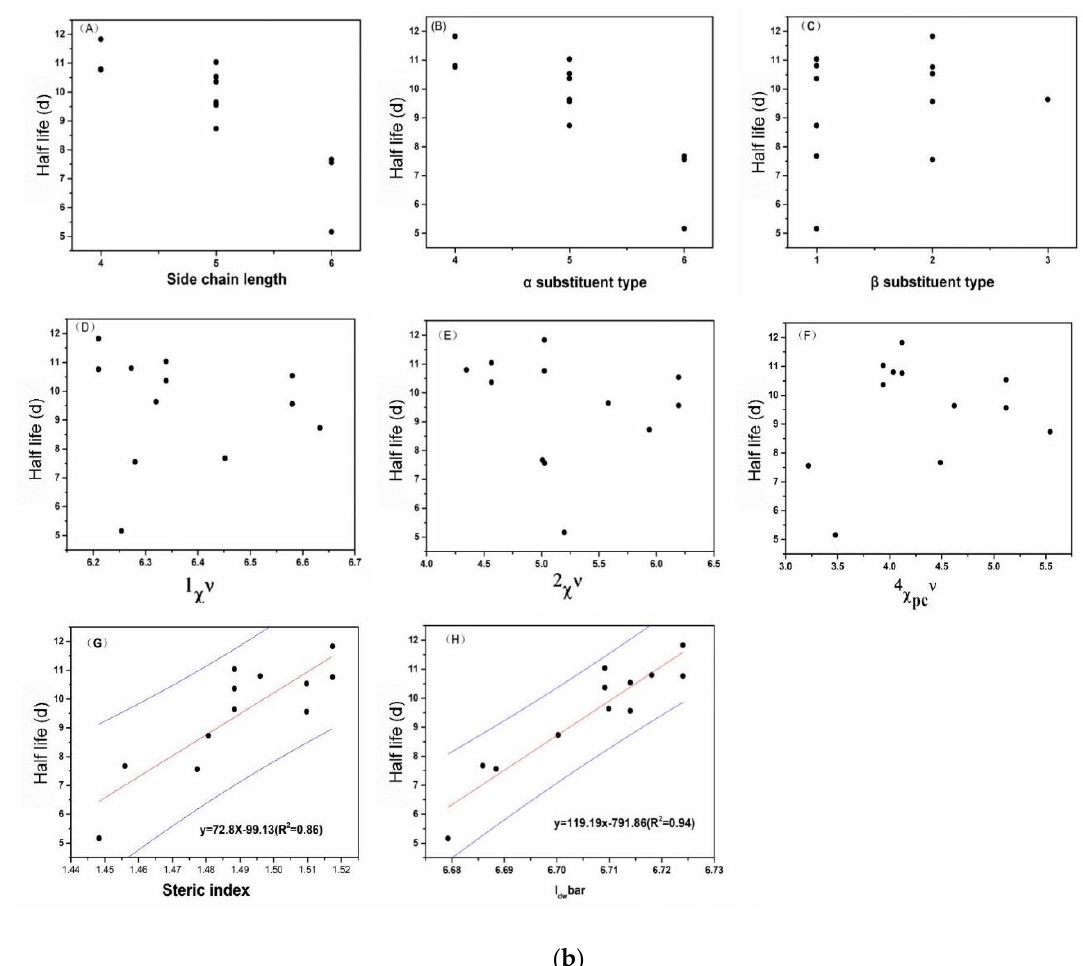
Figure 2. The relationship between the half-life of NP isomers and the structures in China soil ( a ) and Florida soil ( b ). Note: ( A ) The length of the side chain, which was divided to 4, 5, and 6 according to the number of carbon atoms. ( B ) The type of α substitute: 1, dimethyl; 2, ethyl methyl; 3, methyl propyl. ( C ) The type of β substitute: 1, none; 2, methyl; 3, ethyl. ( D – F ) Molecular connectivity. ( G ) Steric index. ( H ) Mean information index for the magnitude of distance. Each black point represents the isomer; the red solid line represents the regression line and the blue solid line represents the 95% confidence limit.